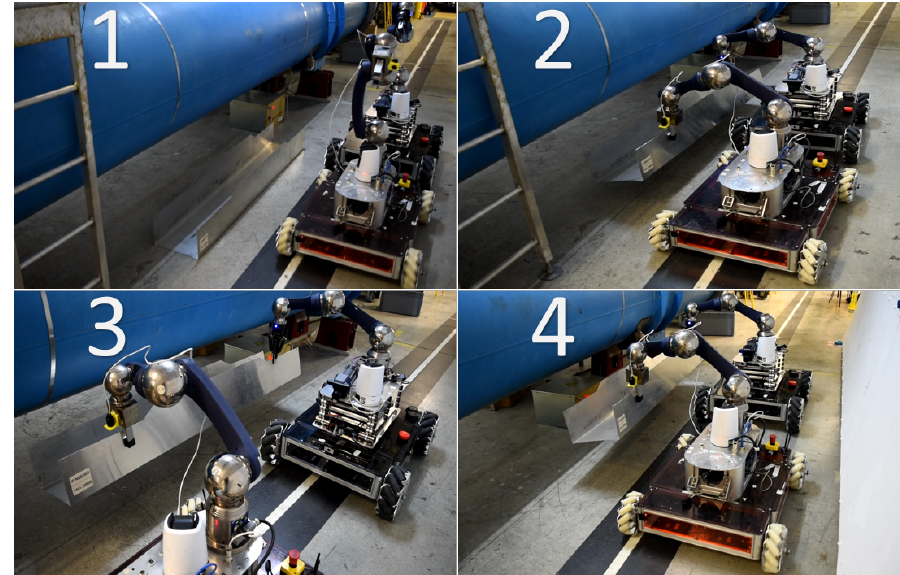
Figure 14. Task sequence carried out by two cooperative robots: ( 1 ) approaching the target, ( 2 ) grasping, ( 3 ) lifting, and ( 4 ) transporting.